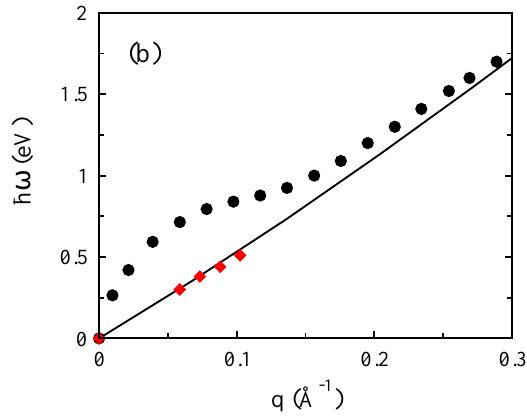
Figure 6. ( a ) The loss spectra for different values of q and ( b ) the plasmon dispersion of doped bilayer graphene with E F = 0.7 eV corresponding to n = 9.5 × 10 13 cm − 2 along the Γ − M direction. The diamond symbols refer to the acoustic plasmon